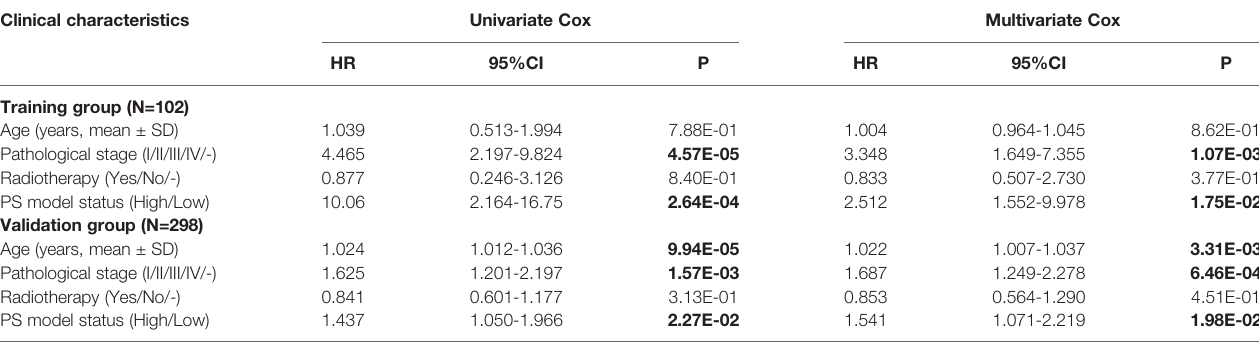
TABLE 3 | Univariate and multivariate analyses of the prognostic model. Clinical